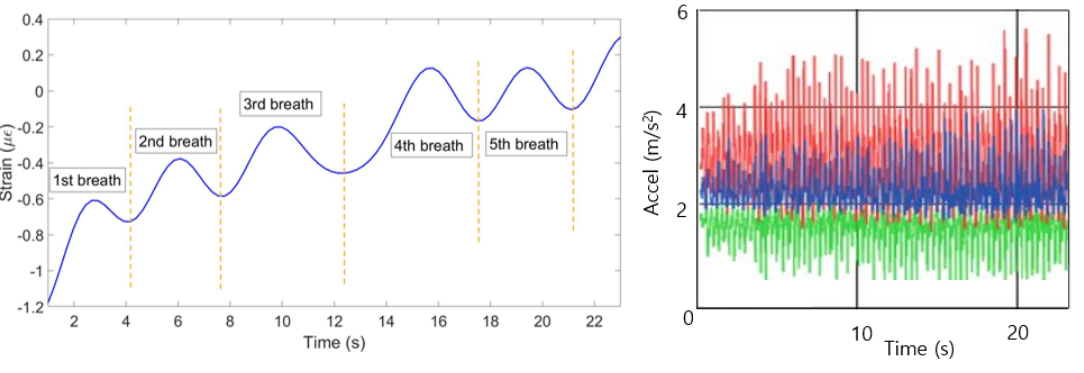
Figure 23. Breathing pattern for the first volunteer in the running position reconstructed based on the 10 FBGs strain patterns ( left ) and obtained from the reference sensor ( right ).